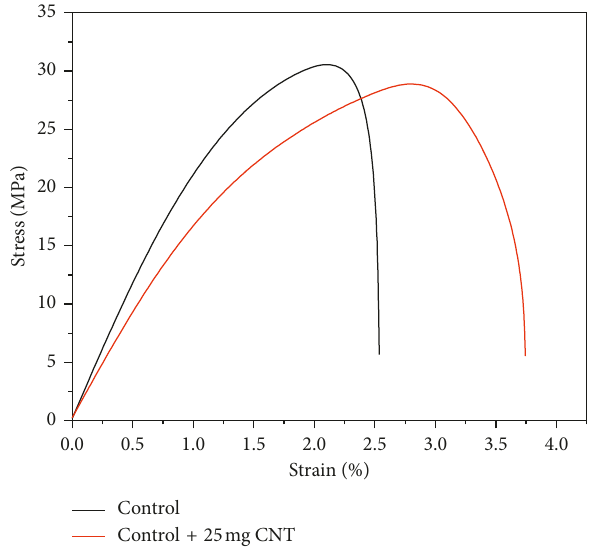
Figure 1: Stress-strain plots of the polymer composite and control (neat PE).